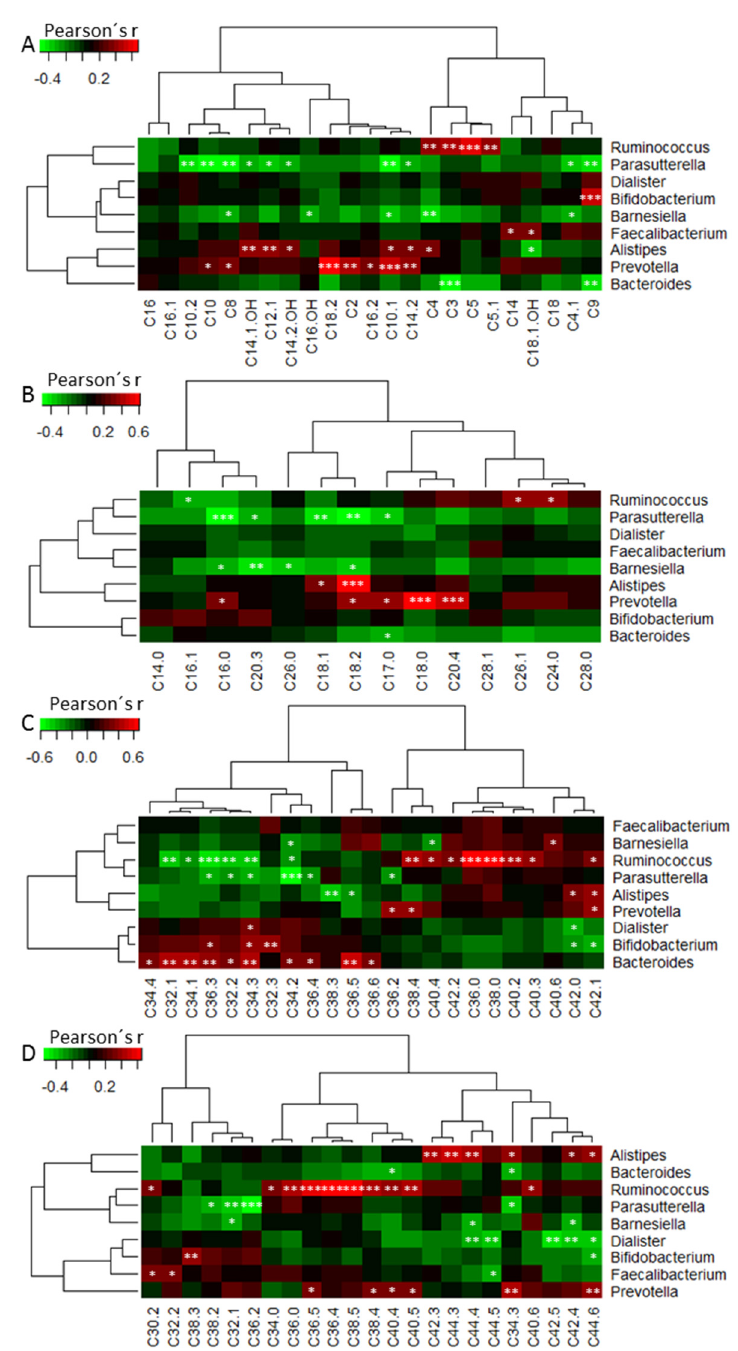
Figure 6. Correlation heatmap (Pearson’s correlation) of most abundant gut microbiota on genus level and plasma metabolites. Microbiota vs. ( A ) acylcarnitines, ( B ) lyso-phosphatidylcholines, ( C ) diacyl-phosphatidylcholines, ( D ) acyl-phosphatidylcholines. Green colored field figure negative and red colored positive correlations. Hierarchical clustering of microbiota abundance and clinical parameter are shown by dendograms.